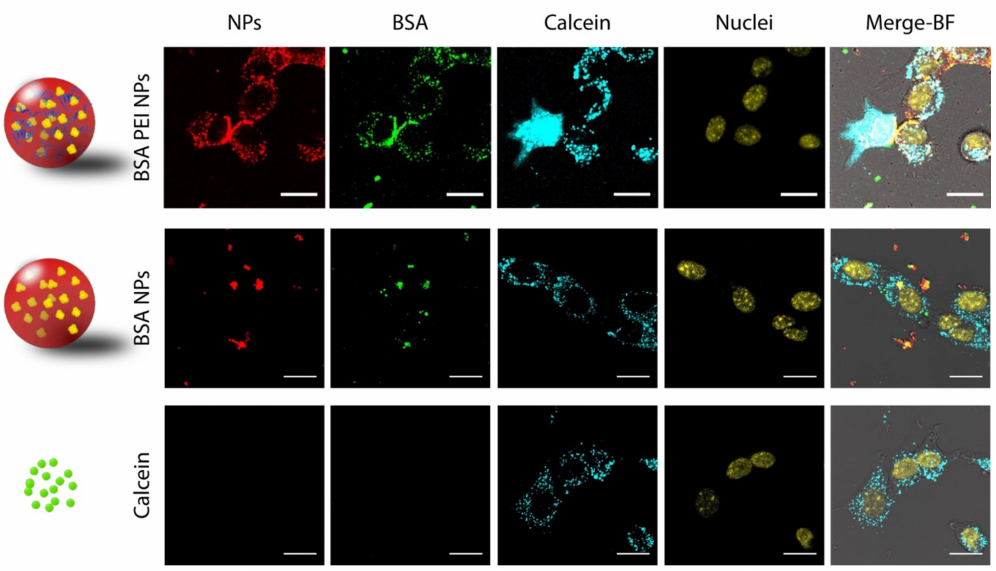
Figure 2. Representative confocal images of NIH-3T3 cells treated with BSA PEI NPs, BSA NPs or Calcein. Scale bars: 20 µ